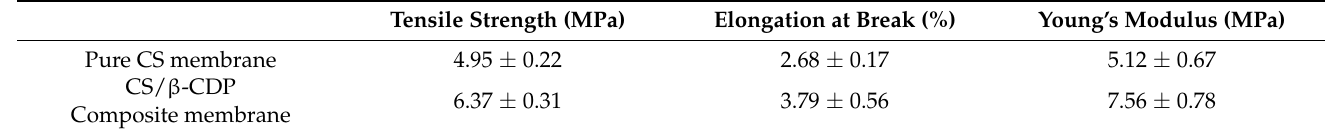
Table 4. Results of mechanical property.